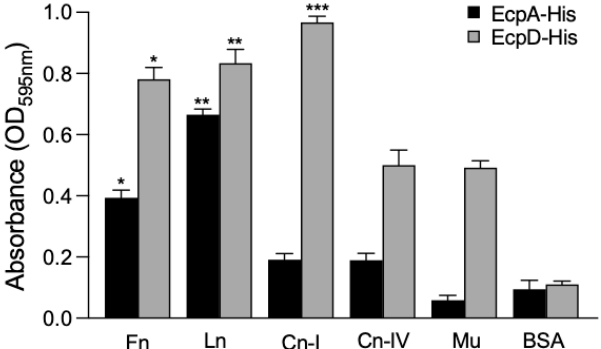
Figure 5. Binding of recombinant His-tagged EcpA and EcpD proteins to ECM glycoproteins and Mu. ELISA was performed to determine the binding of purified recombinant His-tagged Ecp proteins after 1 h incubation at room temperature to immobilized ECM glycoproteins and Mu. BSA was used as a negative control. Data shown are the mean of three experiments performed in triplicate on different days (Kruskal–Wallis test, * p < 0.05; ** p < 0.01; *** p <